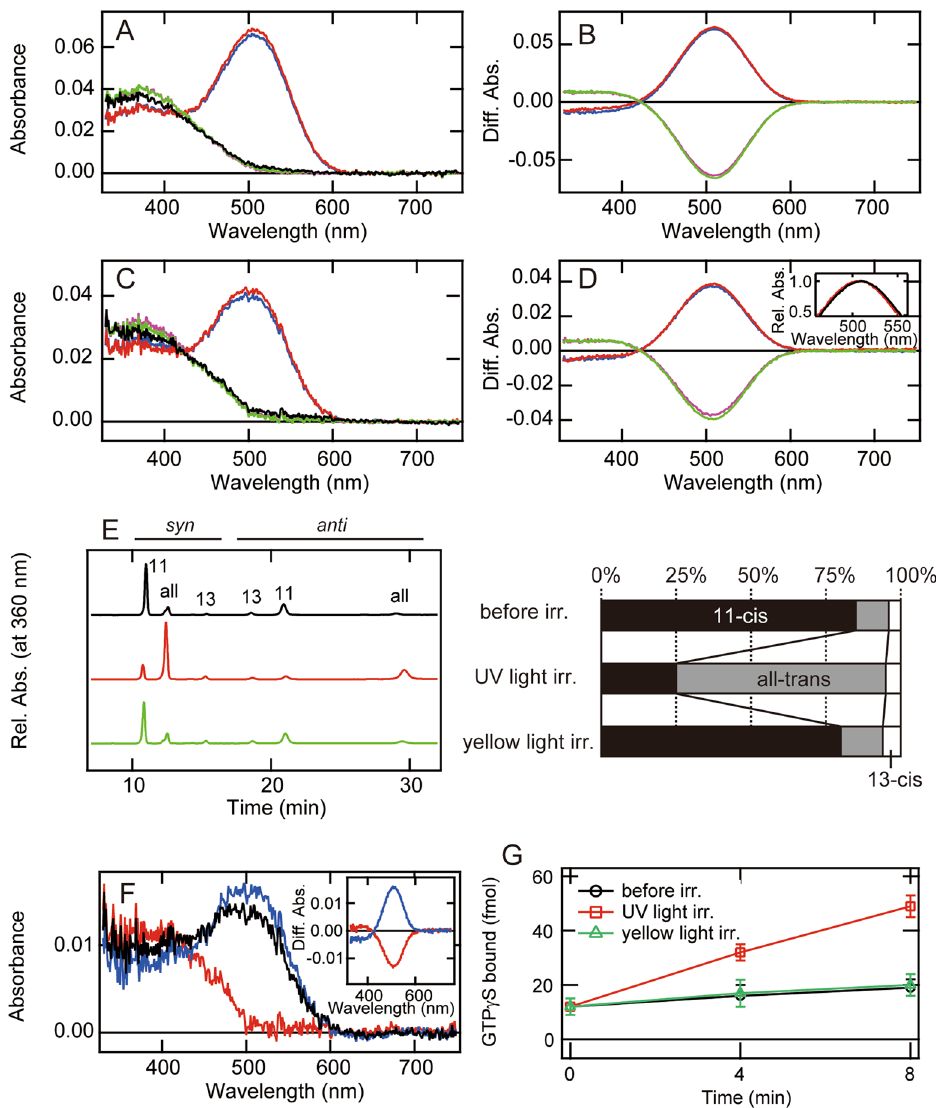
Figure 3. Molecular properties of purified Drosophila Rh7. ( A – D ) Absorption spectra of Rh7-Cap purified after it was regenerated with 11- cis -retinal ( A , B ) or 11- cis -3-hydroxyretinal ( C , D ). ( A , C ) Spectra were measured in the dark (black curve), after UV light irradiation (red curve), after subsequent yellow light ( > 500 nm) irradiation (green curve), after UV light re-irradiation (blue curve), and after yellow light re- irradiation (violet curve). ( B , D ) Difference spectra calculated based on the spectra in ( A ) or ( C ). The red curve was calculated by subtracting the spectrum before from that after UV light irradiation. The green curve was calculated by subtracting the spectrum after UV light irradiation from that after subsequent yellow light irradiation. The blue curve was calculated by subtracting the spectrum after yellow light irradiation from that after UV light re-irradiation. The violet curve was calculated by subtracting the spectrum after UV light re-irradiation from that after yellow light re-irradiation. The inset of ( D ) shows a comparison of the spectral properties of Rh7-Cap reconstituted with 11- cis -retinal (black curve) and 11- cis -3-hydroxyretinal (red curve). Difference spectra caused by UV light irradiation shown by red curve in ( B ) and ( D ) were normalized to be ~1.0 at the positive maxima. ( E ) Light-dependent retinal configuration changes of 11- cis -retinal bound Rh7-Cap. Left-hand panel , the retinal configurations were analyzed with HPLC after extraction of the chromophore as retinal oximes ( syn and anti forms of 11- cis -, 13- cis -, and all- trans -retinal oximes). Right-hand panel , isomeric compositions of retinal before and after light irradiation. ( F ) Absorption spectra of Rh7-Cap purified after it was regenerated with all- trans -retinal. Spectra were measured in the dark (black curve), after yellow light ( > 500 nm) irradiation (red curve), and after subsequent UV light irradiation (blue curve). Inset , Difference spectra calculated by subtracting the spectrum before from that after yellow light irradiation (red curve) and the spectrum after yellow light irradiation from that after subsequent UV light irradiation (blue curve). ( G ) Time courses of G protein activation ability of Rh7-Cap reconstituted with 11- cis -retinal. Gq activation abilities were measured in the dark (black line), after UV light irradiation (red line), and after subsequent yellow light irradiation (green line). Data are presented as the means ± S.E. of three independent